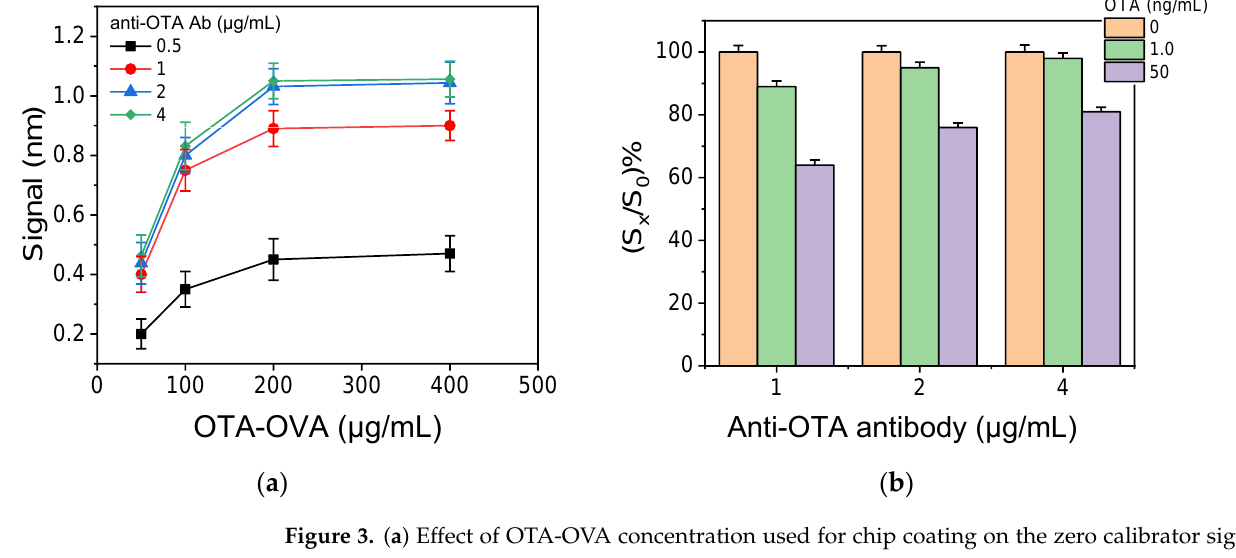
Figure 3. ( a ) Effect of OTA-OVA concentration used for chip coating on the zero calibrator signal received for anti-OTA antibody concentrations of 0.5 (black squares), 1.0 (red circles), 2.0 (blue triangles), or 4.0 μg/mL (green diamonds). The primary immunoreaction duration was 15 min. Each point is the mean value of three measurements ± SD. ( b ) Effect of anti-OTA antibody concentration on the percent signal values obtained for calibrators, containing 1.0 (green columns) and 50 ng/mL OTA (purple columns), with respect to zero calibrator (orange columns). The chip was coated with a 200 μg/mL OTA-OVA solution. Each point is the mean value of three measurements ± SD.